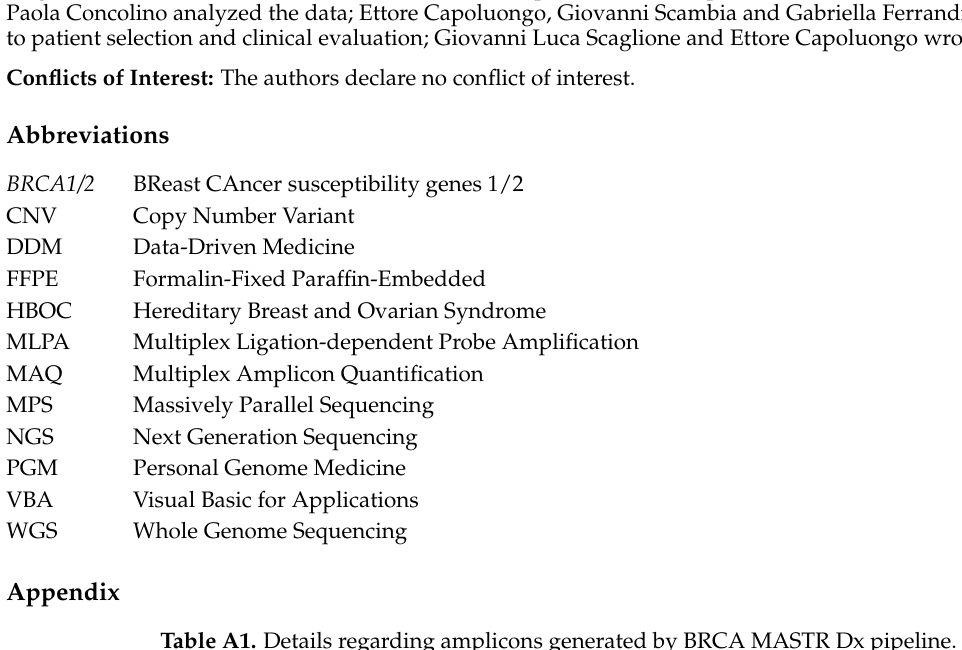
Table A1. Details regarding amplicons generated by BRCA MASTR Dx